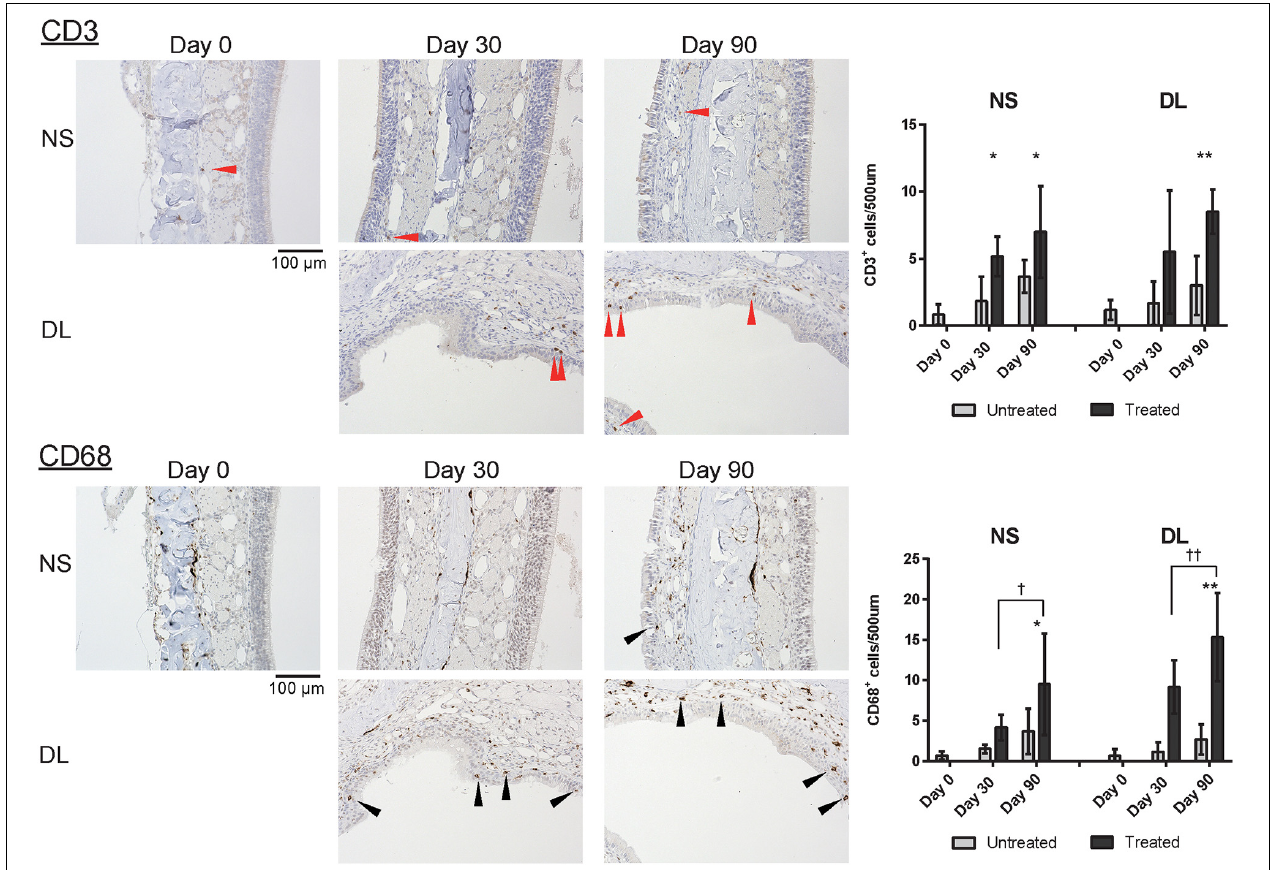
FIGURE 7 | Representative images of sections of the nasal mucosa stained with antibodies against CD3 and CD68 (magnification, 200 × ). NS, nasal septum; DL, dorsolateral area. CD3 + T lymphocytes (red arrowheads) and CD68 + macrophages (black arrowheads) in the nasal mucosa were identified by immunohistochemical staining (brown). Graphs show the number of each cell type per 500 µ m of basal layer length. * P < 0.05; ** P < 0.01; † P < 0.05; and ‡ P < 0.01 ( n = 6, one-way analysis of